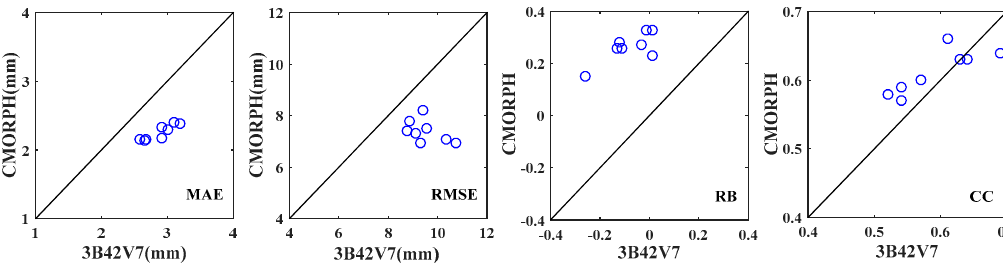
Figure 6. The correlations of different indicators between 3B42V7 and CMORPH at the daily scale.